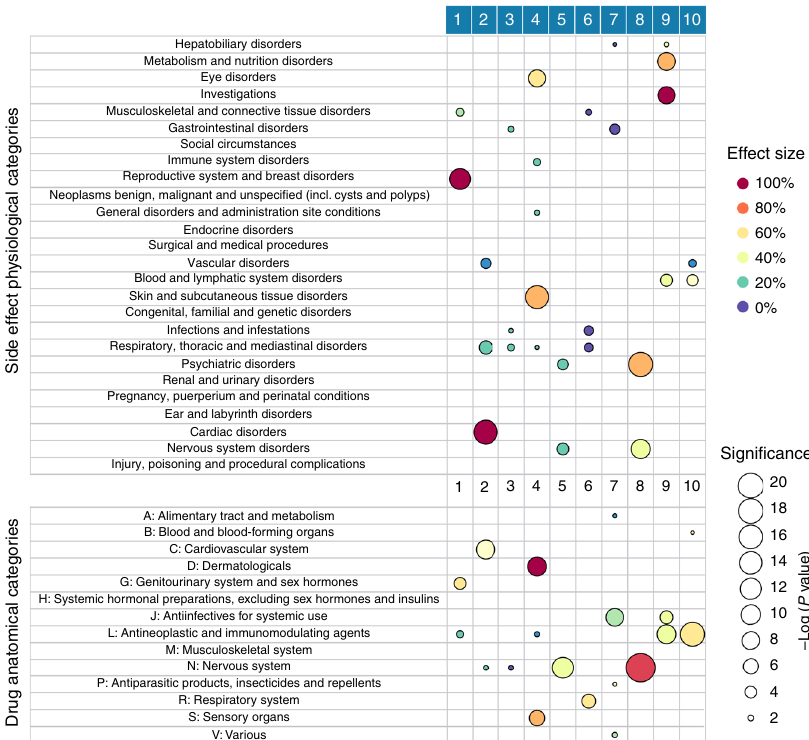
Fig. 6 Summary of statistically signi fi cant signature activations. Drugs were grouped based on their main Anatomical, Therapeutic and Chemical (ATC) classes while side effects were grouped by their System Organ Class (SOC) categories in MedDRA. Only statistically signi fi cant associations (one-tailed Wilcoxon sum-rank test with Benjamini – Hochberg adjusted signi fi cance, P < 0.05) are shown. The size of the circle represents the signi fi cance ( P value), and the colour encodes the effect size of the association — the difference between median in the group compared to the median of all drugs (or side